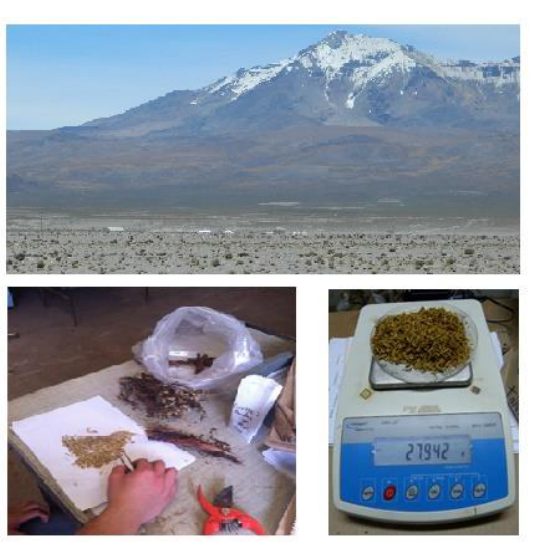
Figure 1: Study area.